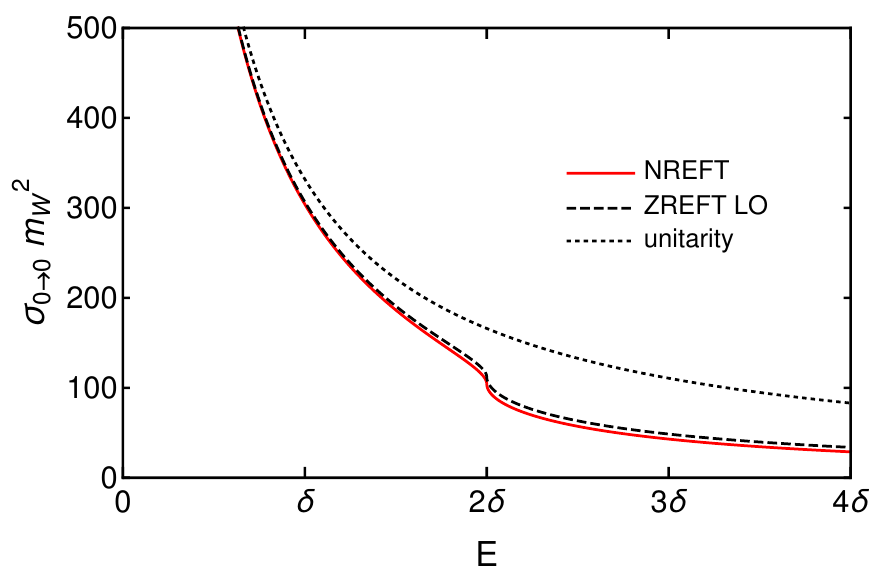
Figure 12 . The neutral-wino elastic cross section (cid:27) 0 ! 0 as a function of the energy E . The cross section for (cid:11) = 0 at the unitarity mass M (cid:3) = 2 : 88 TeV is shown for NREFT (solid line) and for ZREFT at LO (dashed line). The S-wave unitarity bound is shown as a dotted line. denominator of eq. (5.6), which switches from pure real to pure imaginary as the energy E crosses the